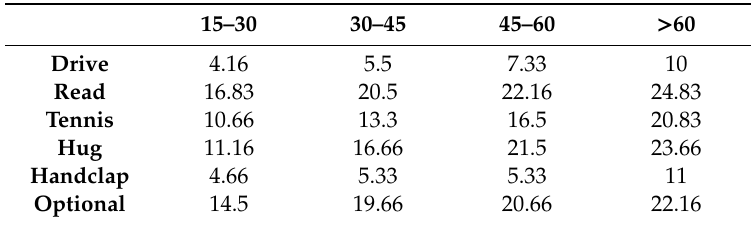
Table 4. Mean action recognition time of each age